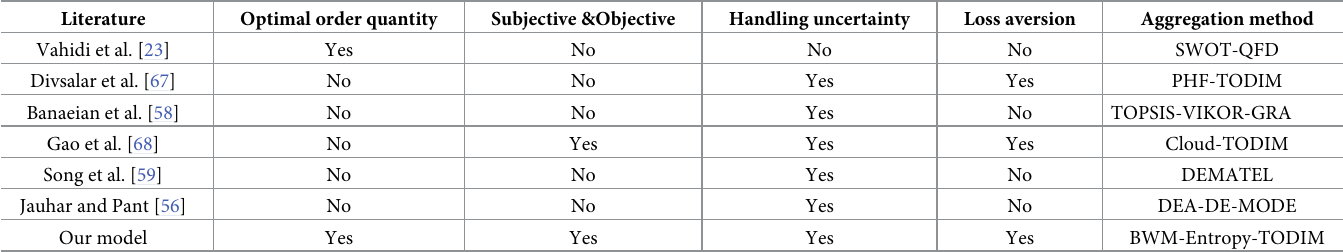
Table 17. Qualitative comparison of MCGDM techniques.